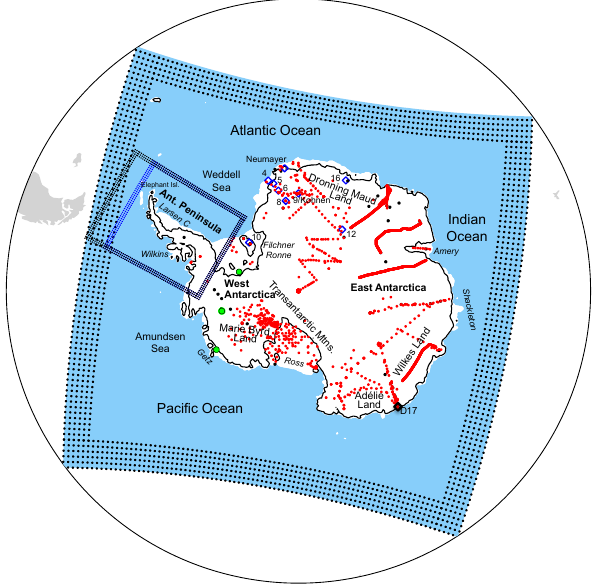
Figure 1. Map of Antarctica showing the in situ SMB obser- vations (red dots), AWSs (blue diamonds), drifting snow mea- surement location D17 (black diamond), three snow radar regions (green dots) and 64 10m snow temperature observations (black dots) used in this study. Shown are the relaxation zones for both RACMO2.3p2/ANT and RACMO2.3p2/AP with the black dotted rectangles, as well as the RACMO2.3p1/AP domain (blue rectangle for the non-overlapping boundary). Also shown are the grounding line in black and relevant locations used throughout the text (with ice shelves in